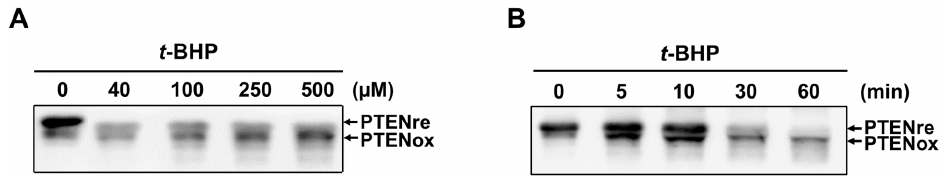
Figure 1. Effects of t- BHP on redox state of recombinant PTEN. Purified recombinant PTEN (oxidized form) was pre-reduced with 1 mM dithiothreitol (DTT) for 2 h in degassed assay buffer prior to being applied to NAP-5 desalting column equilibrated with degassed assay buffer to remove excess DTT. Samples were then incubated with the indicated concentration of t- BHP for 30 min ( A ), or for increasing periods of time with 0.5 mM t- BHP ( B ). After indicated treatment, samples were alkylated with 2 mM NEM. All samples were fractionated by non-reducing SDS-PAGE followed by immunoblot analysis with PTEN antibody. All blot data are representative of at least three separate experiments.